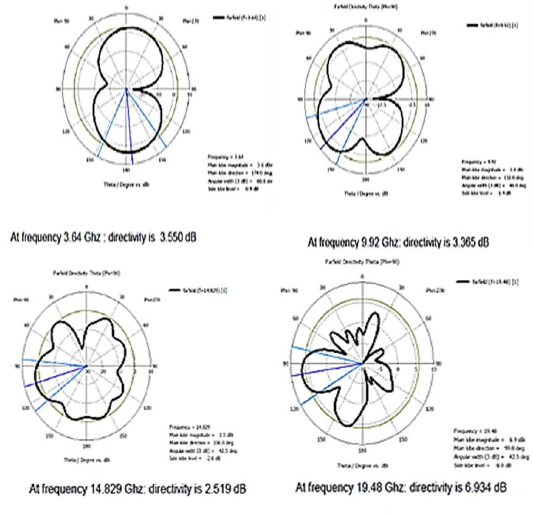
Figure 6: Simulated directivity at 3.64 GHz, 9.92 GHz 14.829 GHz and 19.48